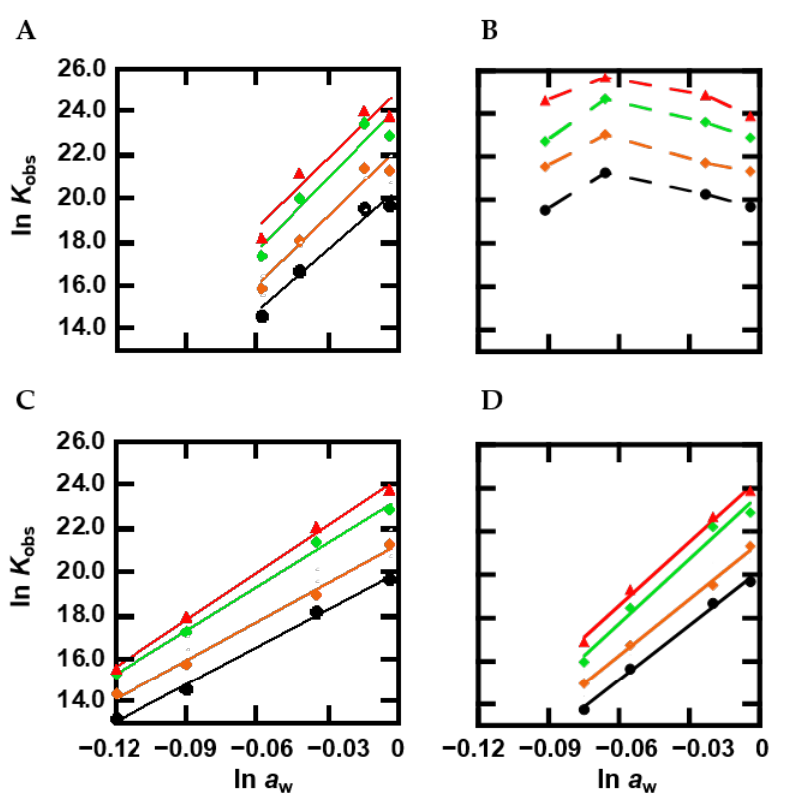
Figure 5. Plots of ln K obs vs. ln a w for DNA duplexes. Plots for Me0 (black circles), Me3 (orange diamonds), Me5 (green diamonds), and Me8 (red triangles) in KCl buffer with PEG200 ( A ), TMAO ( B ), urea ( C ) or L-proline ( D